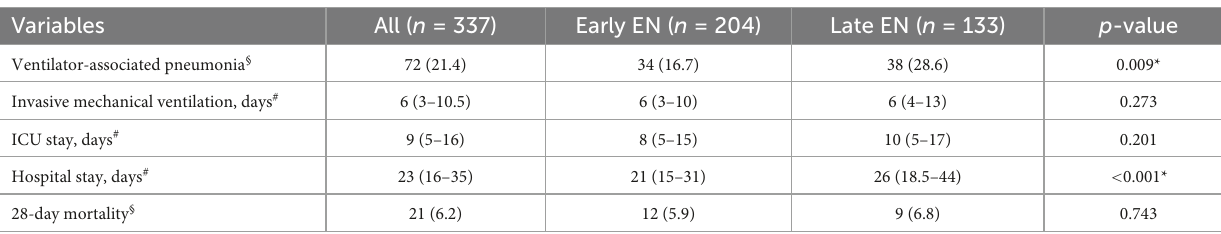
TABLE 2 Outcomes in early and late enteral nutrition